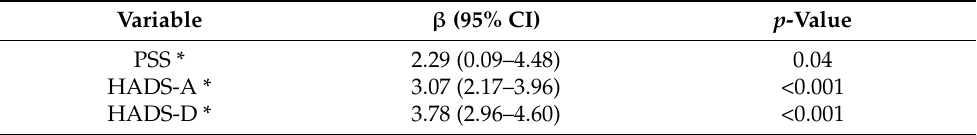
Table 2. Multiple linear regression models assessing the associations of Perceived Stress Scale and Hospital Anxiety and Depression Scale with